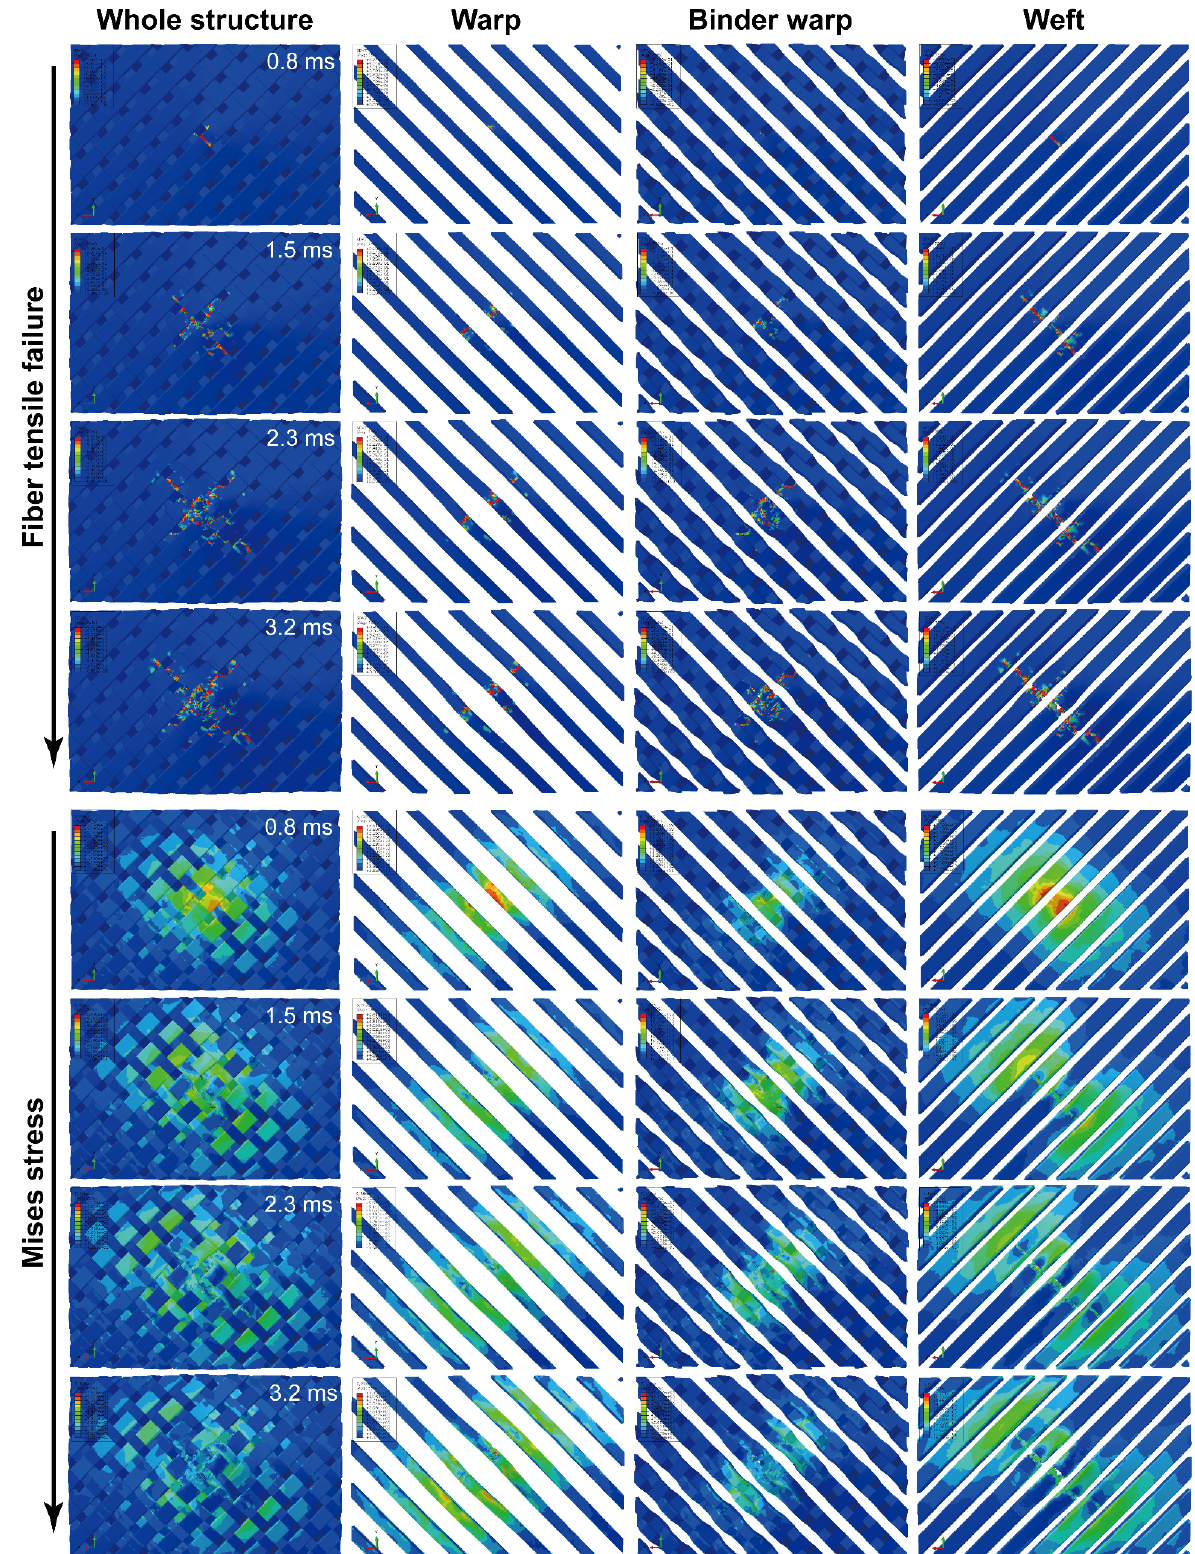
Figure 7. Damage evolutions and corresponding stress distributions of the whole structure and component yarns for a 45° specimen under 47.6 J of impact energy.